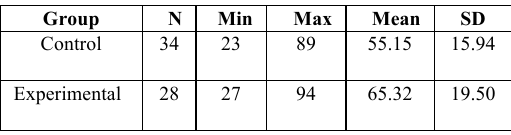
TABLE I. D ESCRIPTIVE STATISTICS FOR THE POST - TEST